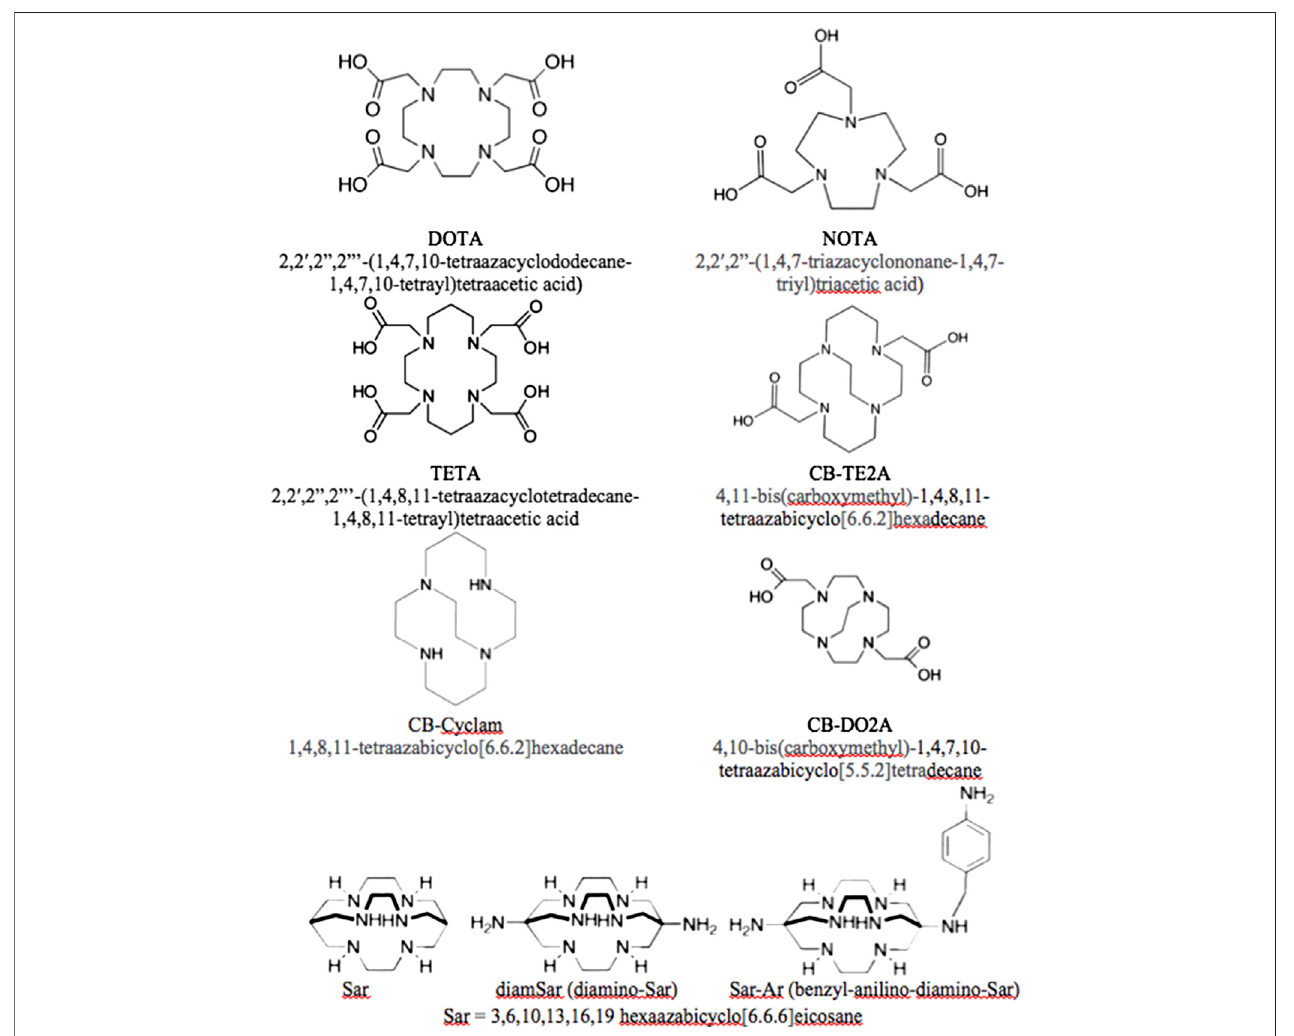
FIGURE 1 | Chelators used for binding radio-copper to